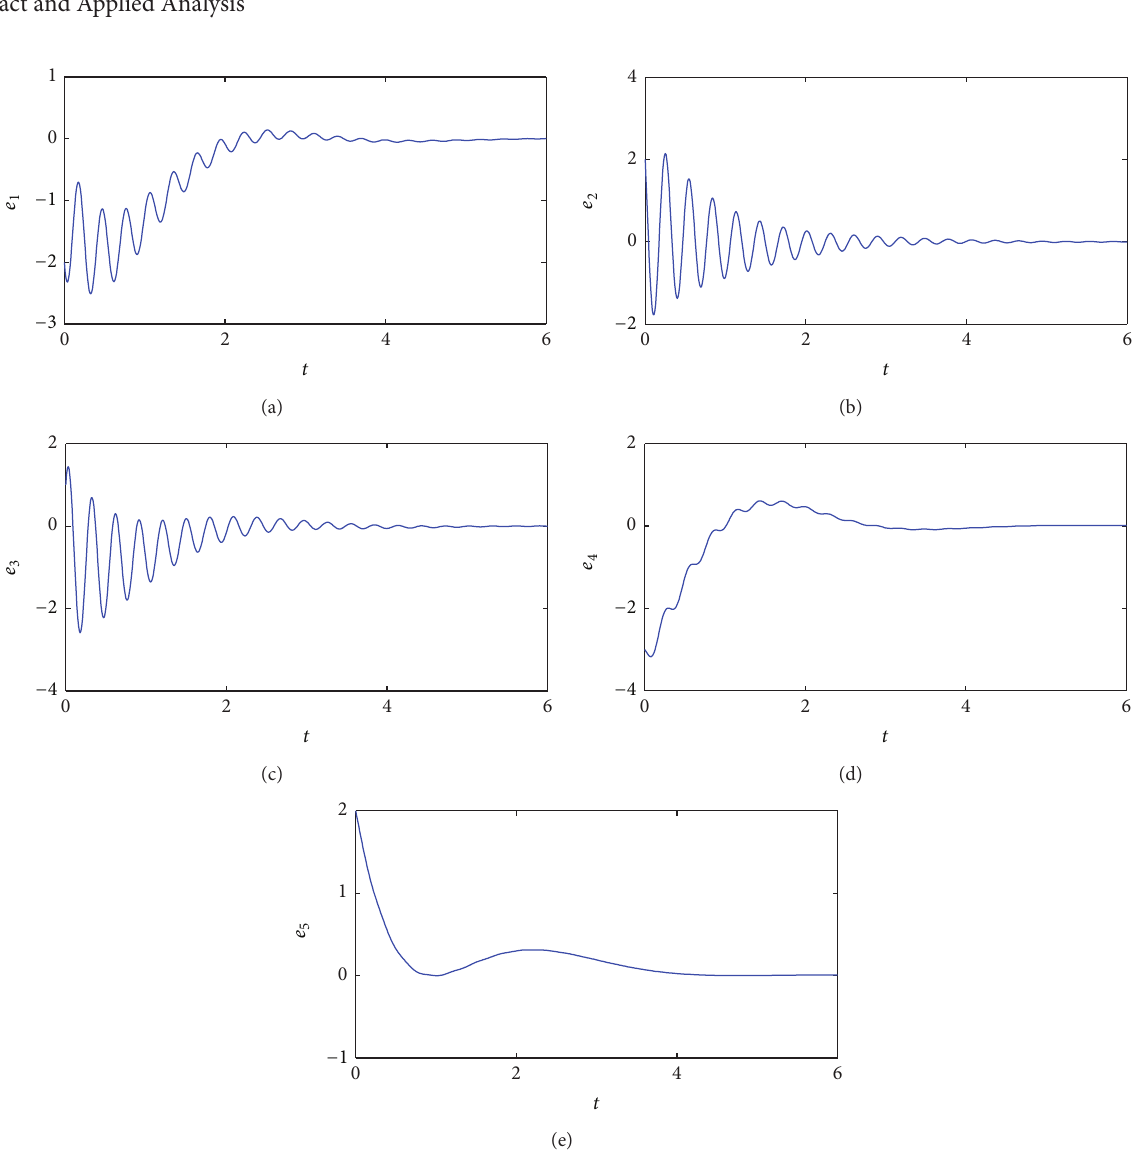
Figure 6: Combination synchronization errors 𝑒 1 , 𝑒 2 , 𝑒 3 , 𝑒 4 , and 𝑒 5 between the drive systems (6) and (7) and the response system (8), where = 𝑢 + V − 𝑤 𝑖 = 1, 2, 3,4, 5 𝑒 𝑖 𝑖 𝑖 𝑖 (